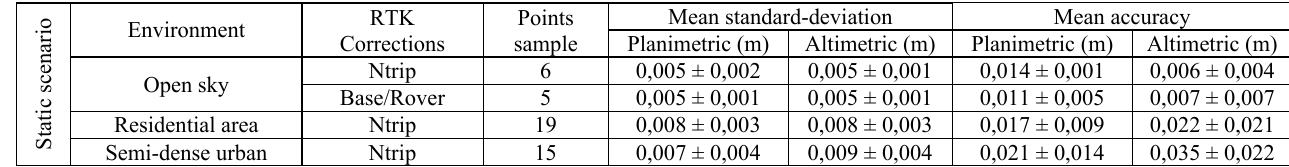
Table 2 : Results achieved with the low-cost receiver in a static scenario